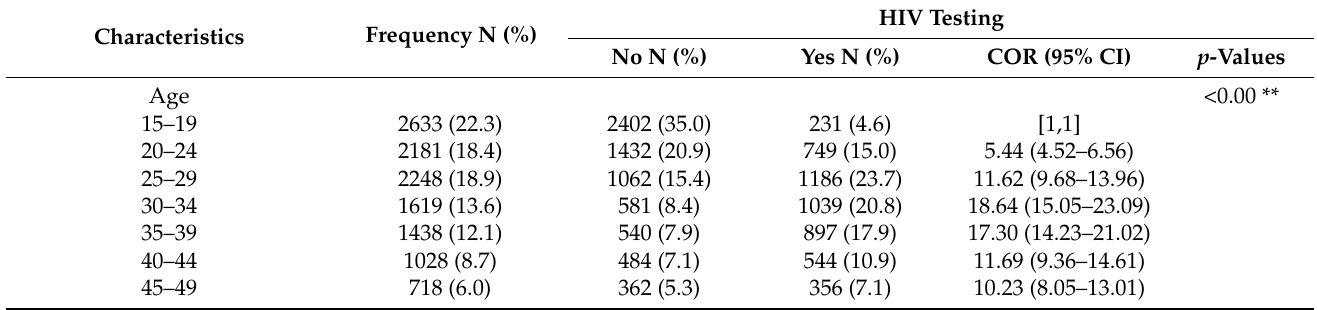
Table 2. Socio-Demographic features and bivariate results of HIV Testing among reproductive women aged 15–49 years in the Gambia, (N =